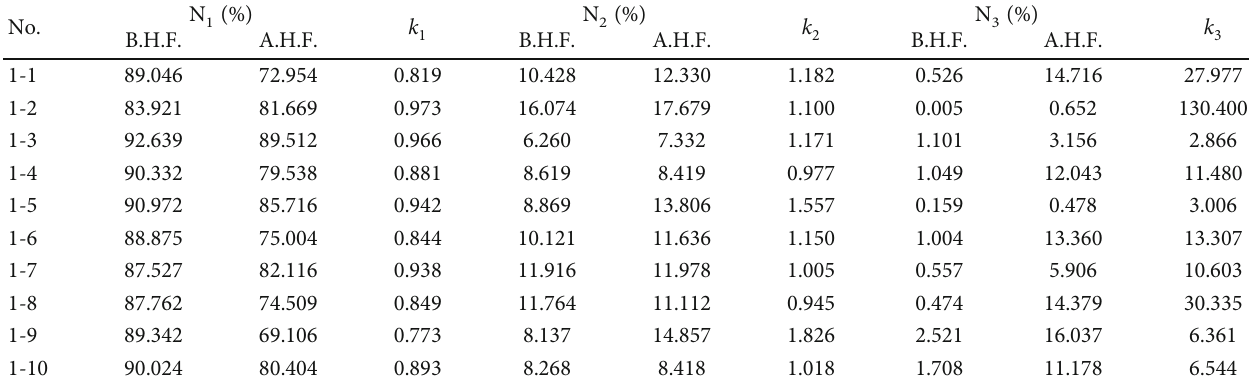
Table 4: Comparison of peak area proportion before and after hydraulic fracturing.